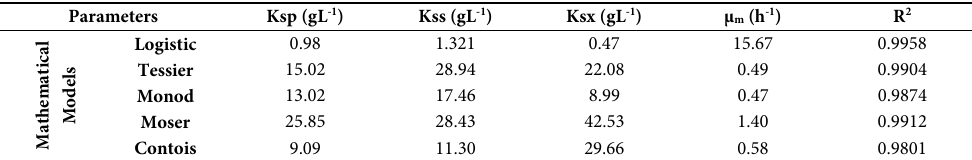
Fig. 6. Diagram related to the mechanism of adsorption under the above conditions. Fig. 6 . Table 2. Kinetic mathematical model parameters for Table 2.